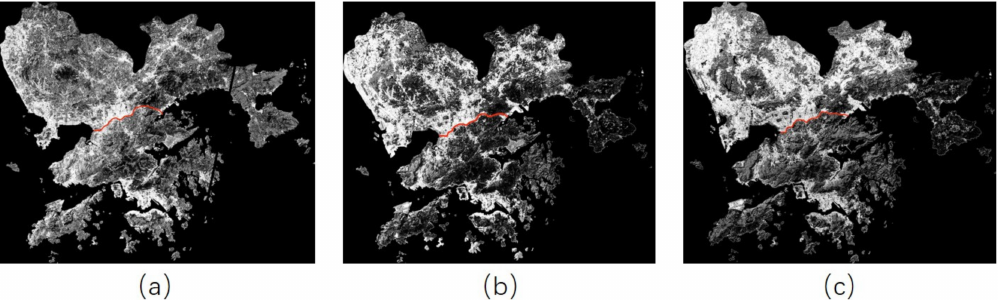
Figure 7. Impervious surface fraction of Hong Kong and Shenzhen: ( a ) 1995; ( b ) 2005; ( c )